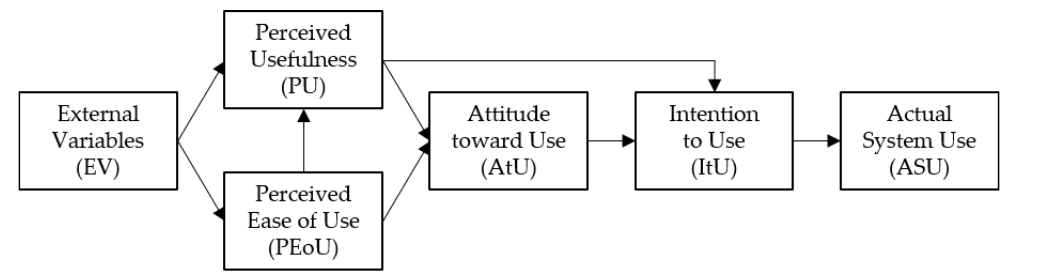
Figure 1. TAM (Technology Acceptance Model).